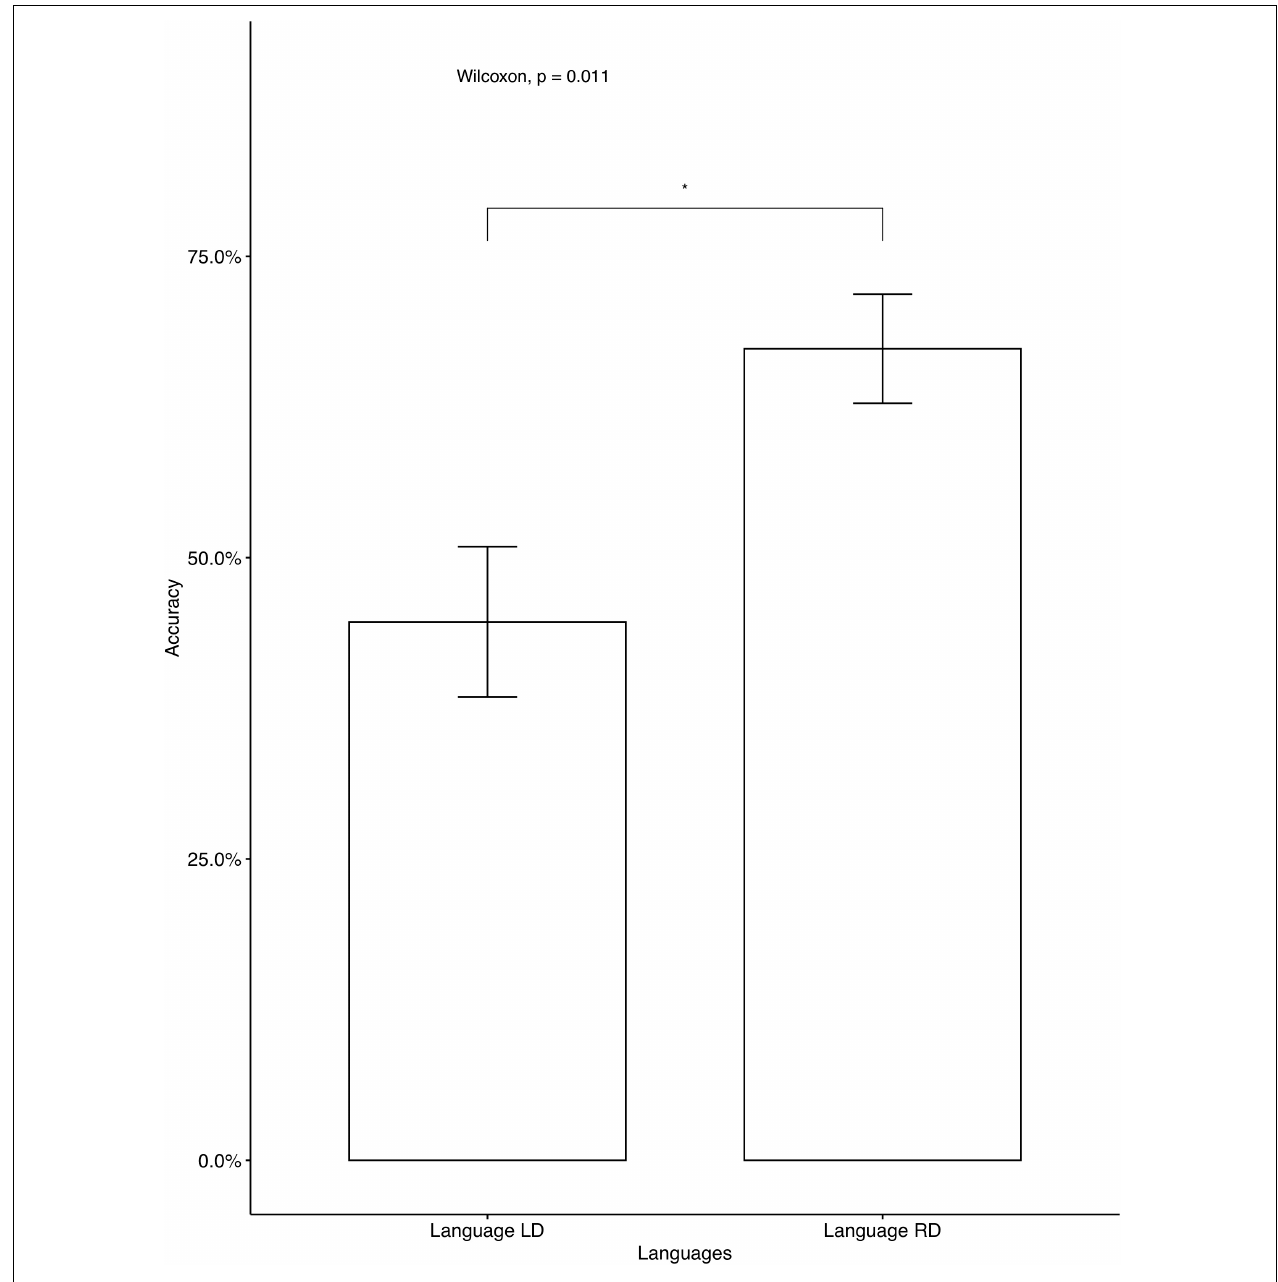
FIGURE 5 | Accuracy on critical seen items: Cantonese native speakers. The 95% confidence interval is specified for each bar. *indicates significant mean difference, p <